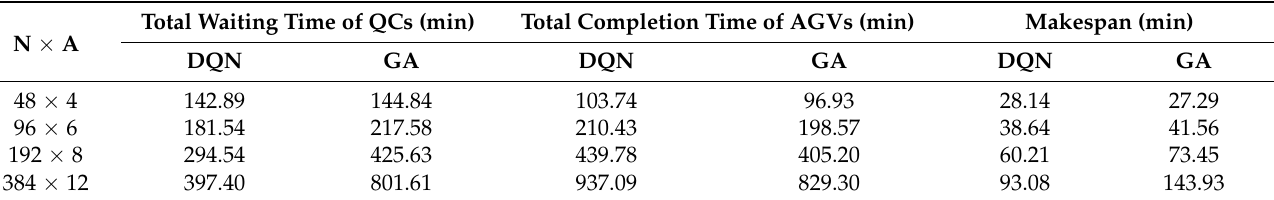
Table 4. Comparison of the results of DQN and GA at different instance scales.